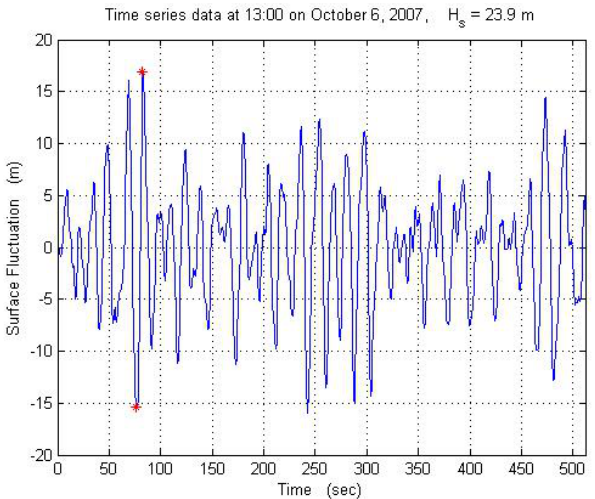
Figure 2. Time series from Gueishantao buoy recorded at 13:00 hour on October 6, 2007 during the height of Typhoon Krosa. Fig. 2. Time series from Gueishantao buoy recorded at 13:00h on 6 October 2007 during the height of Typhoon Krosa.